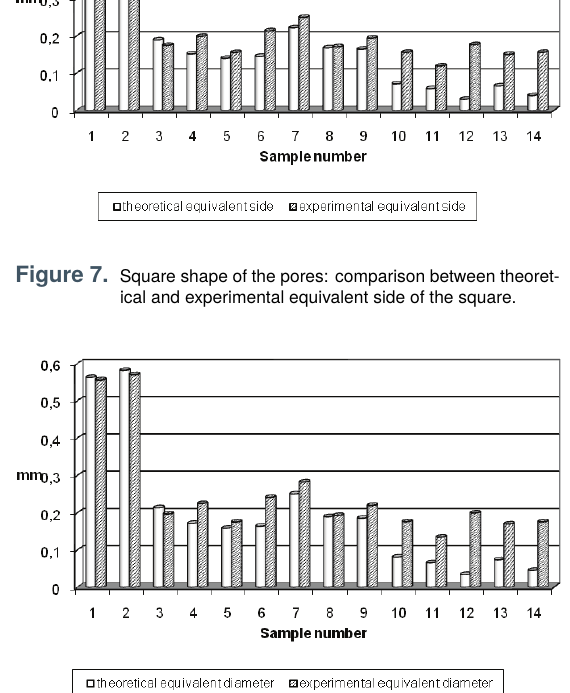
Figure 8. Circular shape of the pores: comparison between theoretical and experimental equivalent diameter of the circle.